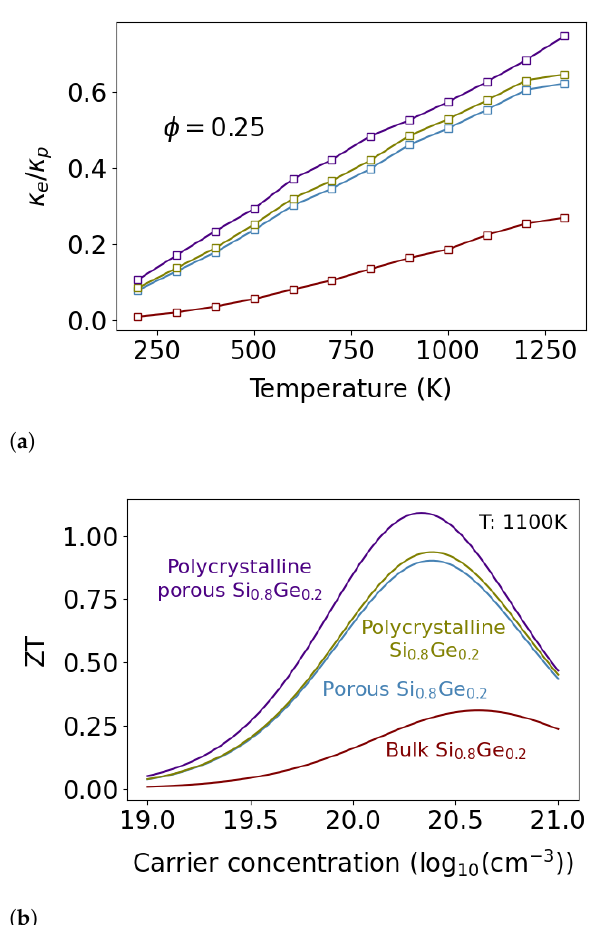
Figure A3. ( a ) The electron thermal conductivity to lattice thermal conductivity ratio versus tem- perature and ( b ) variation of ZT with carrier concentration at 1100 K in bulk pristine Si 0.8 Ge 0.2 in red, porous Si 0.8 Ge 0.2 in blue, polycrystalline Si 0.8 Ge 0.2 in green and polycrystalline porous Si 0.8 Ge 0.2 in